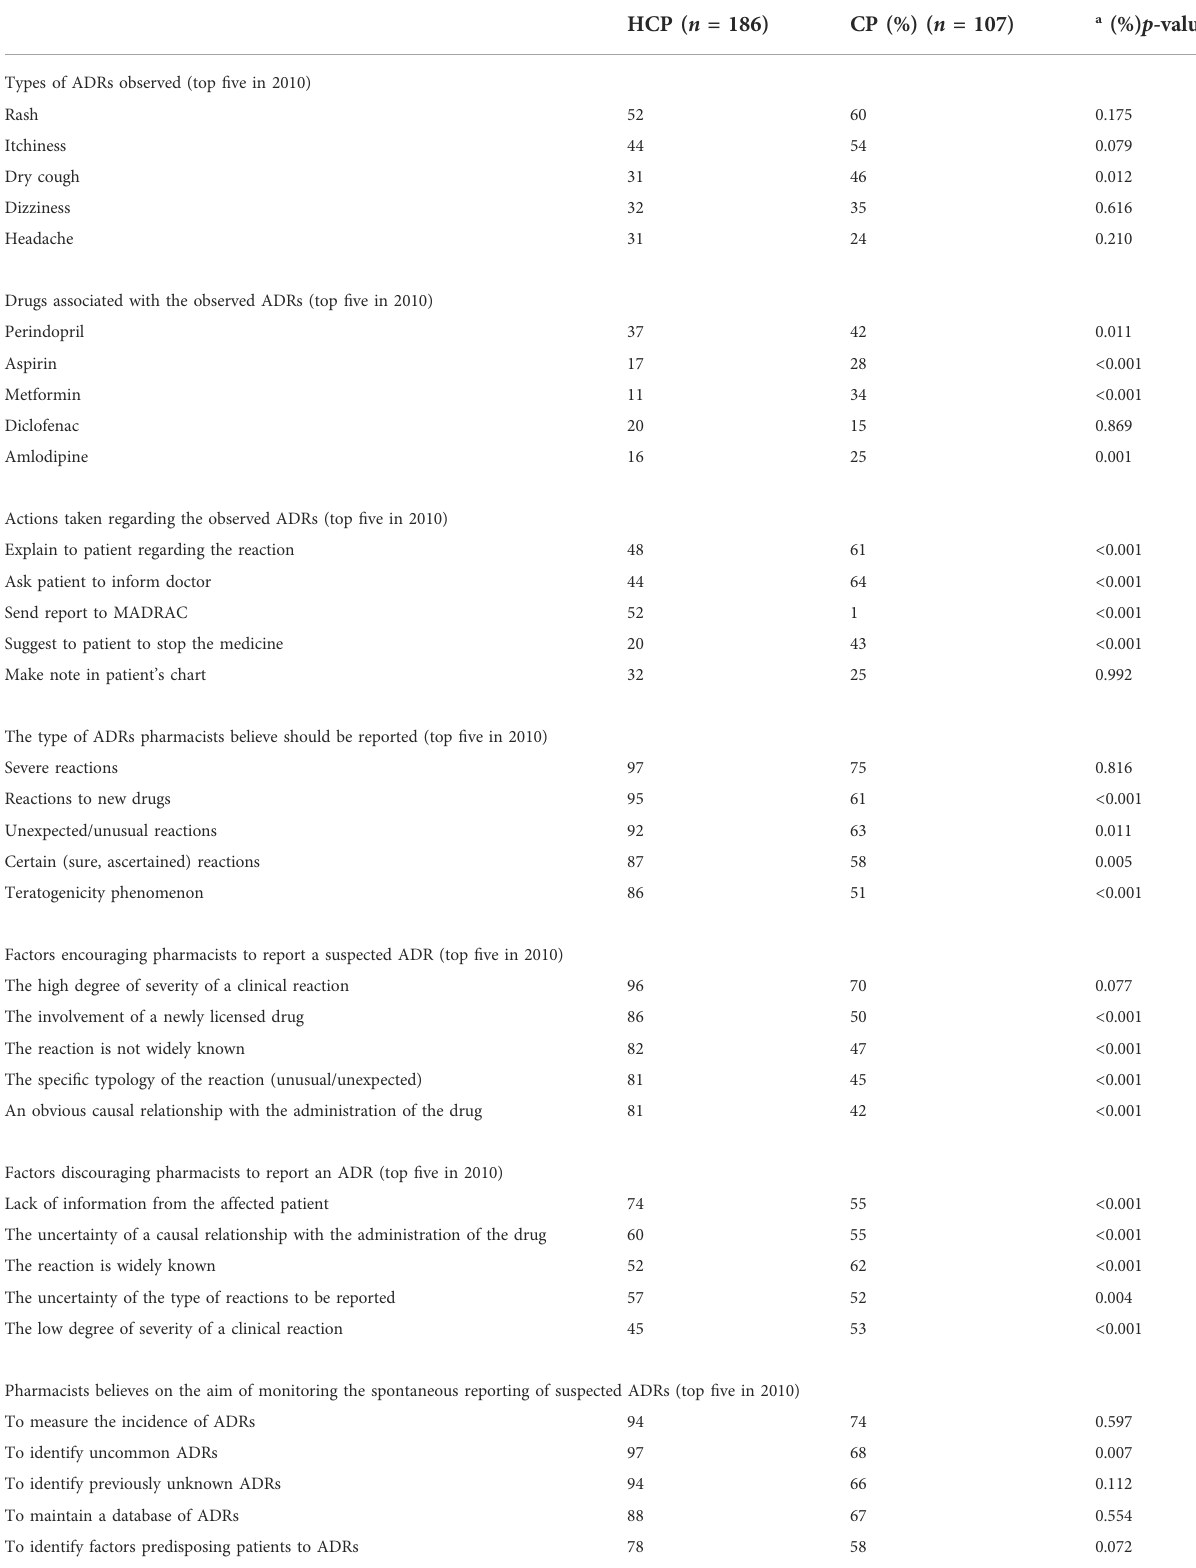
TABLE 2 Comparison between hospital/health clinic pharmacists (HCPs) and community pharmacists (CPs) in